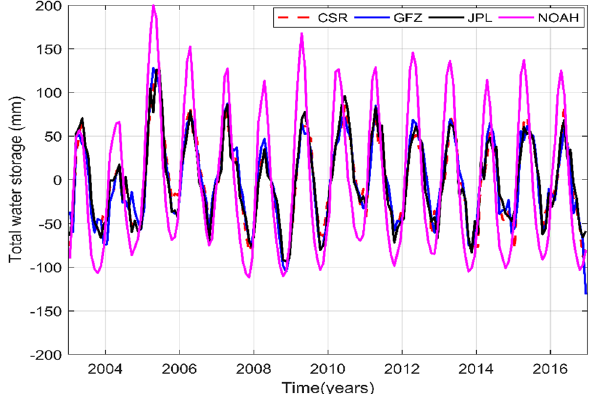
Fig. 2 Residual monthly TWS variations in GB (mm) from GRACE (CSR, GFZ, JPL) and GLDAS-Noah models